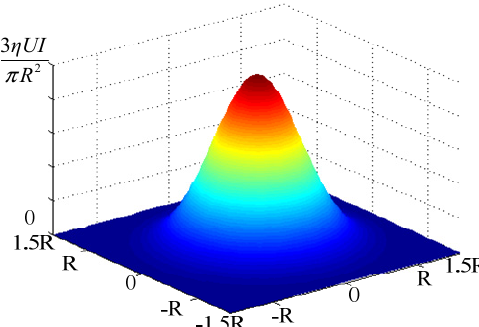
Figure 2. Gauss heat flux distribution (The colors represent the intensity of the heat flux distribution, the red represents the largest, the blue represents the smallest).